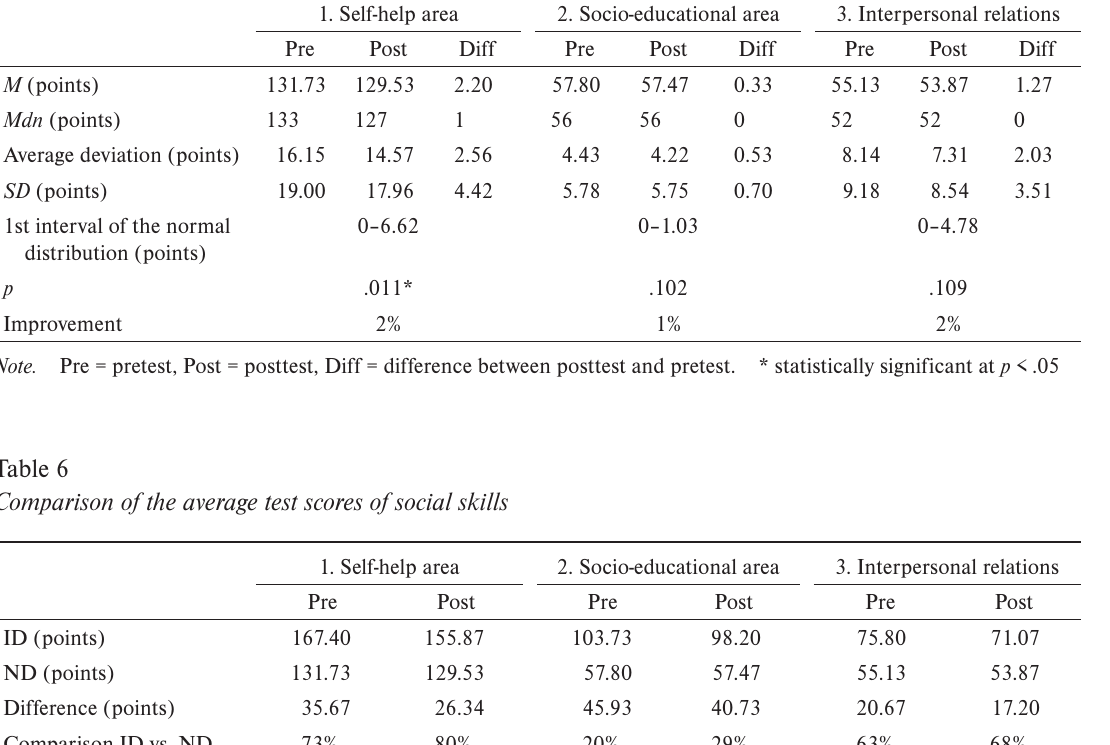
Processing the results of tests in the area of social indicators within the group of non-disabled population 1. Self-help area 2. Socio-educational area 3. Interpersonal relations